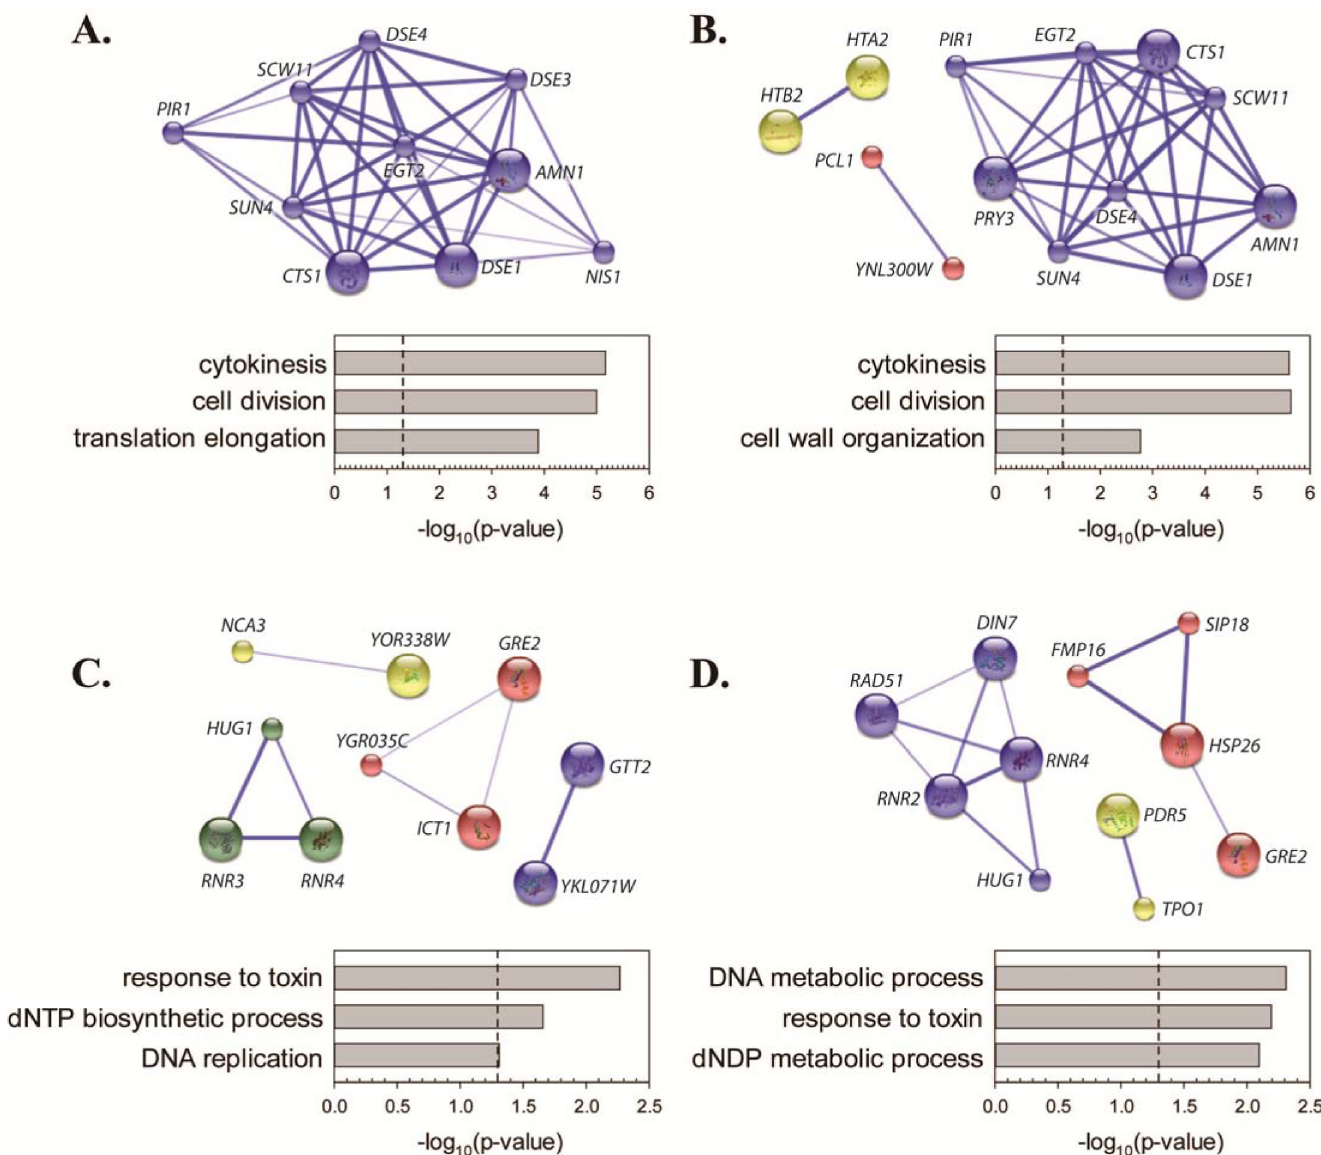
Fig 1. Transcriptomic analysis of KP1019-induced changes in gene expression. Early log phase wild-type yeast were treated with either 80ug/ml (A and C) or 40ug/ml (B and D) KP1019 for three hours. Extraction of RNA and microarray analyses were carried out as described in Materials and Methods. Genes repressed (A and B) and induced (C and D) by KP109 were assembled into clusters using the MCL algorithm on the Search Tool for the Retrieval of Interacting Genes/Proteins database (STRING; http://string-db.org/) [44]. Clusters were predicted with medium confidence and at an inflation level of 3 to allow for identification of a moderate number of clusters. Weak links and disconnected nodes are hidden for clarity. Node size indicates the presence (large nodes) or absence (small nodes) of structural data in the database. Within each cluster, the confidence of each inter-node connection is indicated by the width and intensity of the blue line. Graphs summarize biological process GO term analyses by DAVID. Redundant GO terms (like “ dNTP metabolic process ” ) were omitted in the interest of clarity and